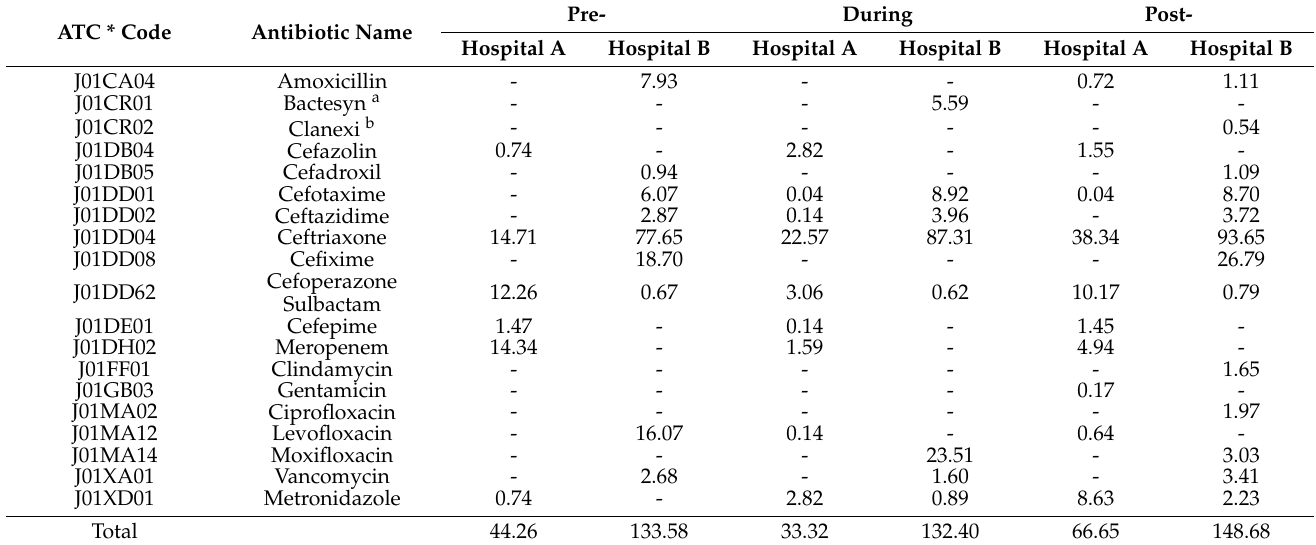
Table 3. The DDD per 100 bed-days antibiotics use for surgical procedures.